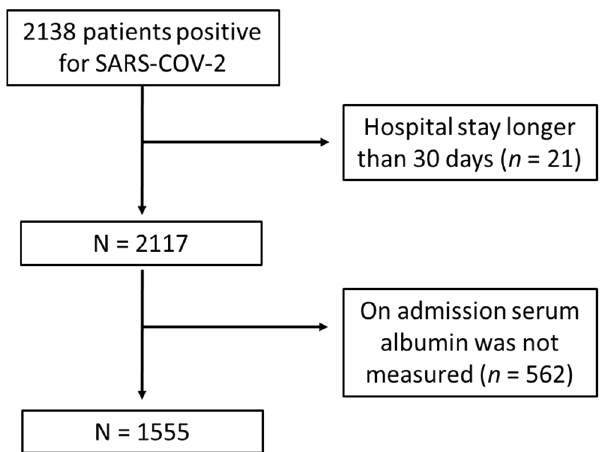
Figure 1. Flow chart of study population inclusion and exclusion criteria. This flow diagram illustrates the resulting number of 1555 recruited patients positive for SARS-CoV-2 admitted for hospitalization in 24 different public hospitals of the community of Madrid (Spain), between August-November 2020; and the number and reasons for excluding COVID-19 patients based our pre-determined criteria. Following this process, 21 patients were removed due to a hospital stay higher than 30 days, while 562 patients were removed because on admission serum albumin was not collected.